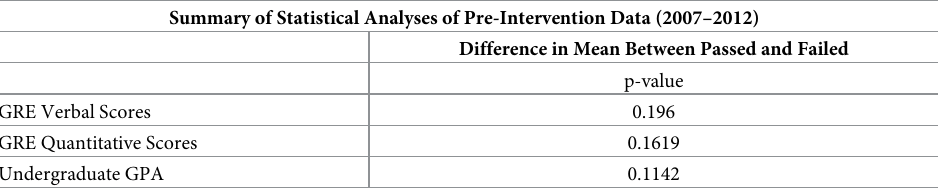
Table 6. Summary of statistical analysis regarding GPA and GRE scores and candidacy exam passage or